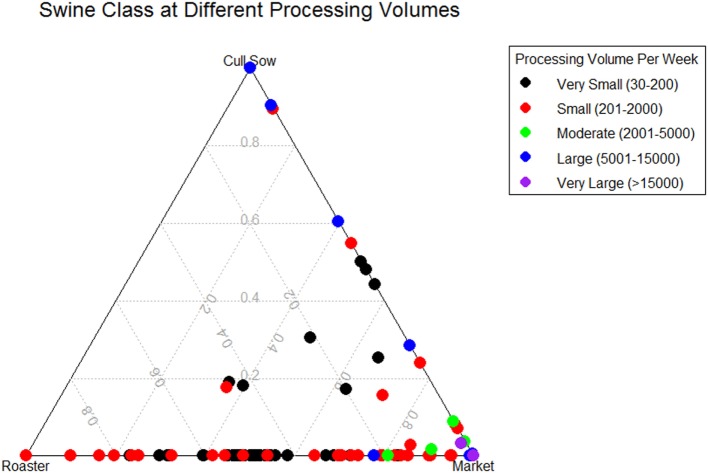
Ternary plot showing the slaughter proportion of three different swine classes (Roaster, Market, Cull Sow) by five plant processing volume per week categories in 149 slaughter plants with temperature and humidity data within 100 miles of plant location for United States Swine from 2010 to 2015.